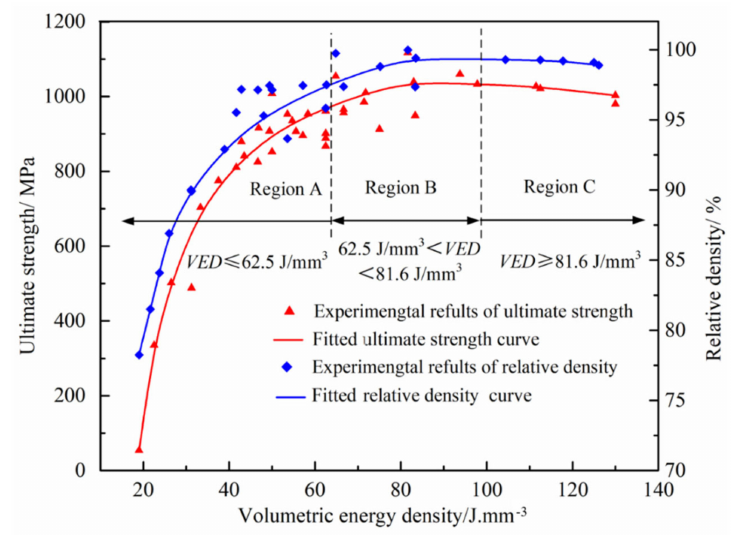
Figure 12. Effect of energy densities on mechanical